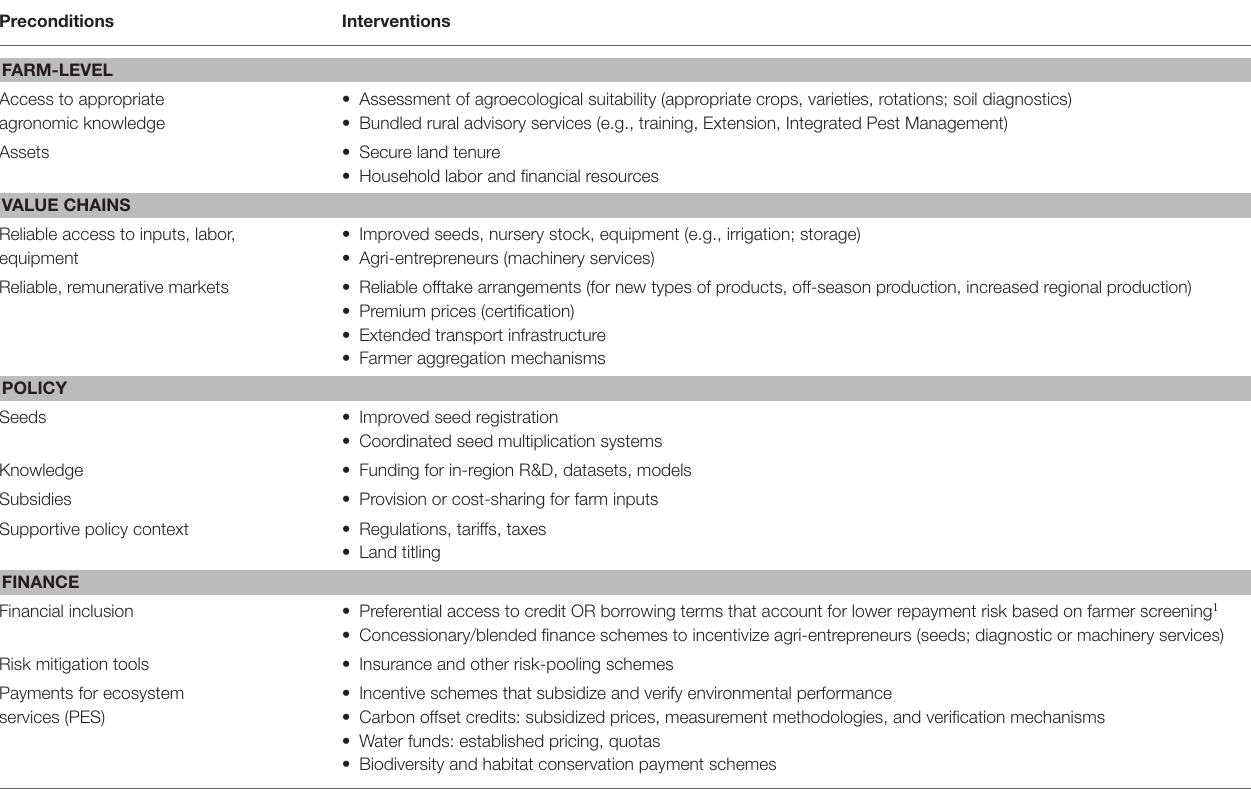
TABLE 2 | Potential interventions to shift toward necessary preconditions for adoption of soil-enhancing